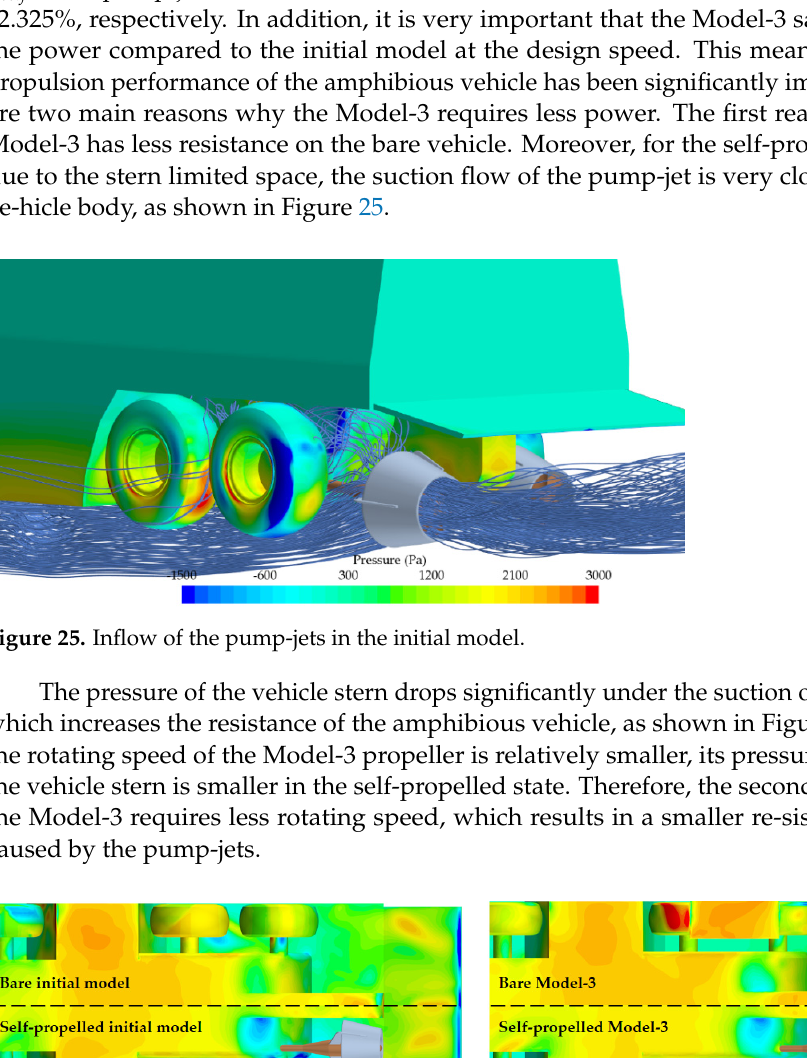
Table 5. Self-propelled characteristics of the initial model and Model-3 at Fr = 0.624.